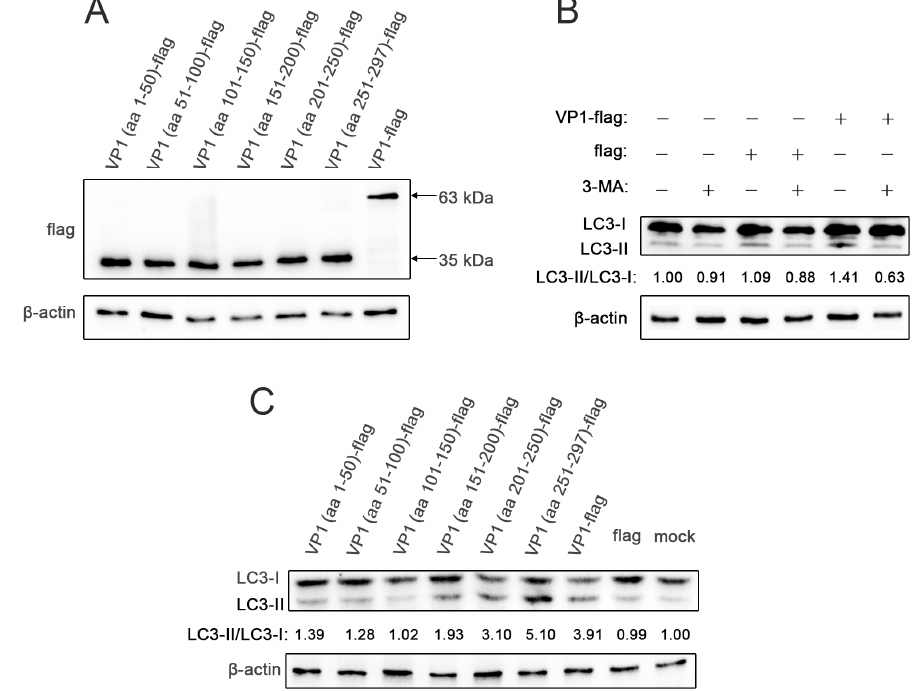
Figure 1. Enterovirus (EV)-A71 VP1 induces autophagy via residues 251–297. ( A ) Vectors expressing six VP1 fragments and full-length VP1 were transfected into HEK293T cells, and proteins were detected by Western blot analysis. ( B ) VP1-flag and flag were transfected into HEK293T cells pretreated with or without 3-MA, and proteins were detected by Western blot analysis. ( C ) HEK293T cells were transfected with different expression vectors, and proteins were detected by Western blot analysis.